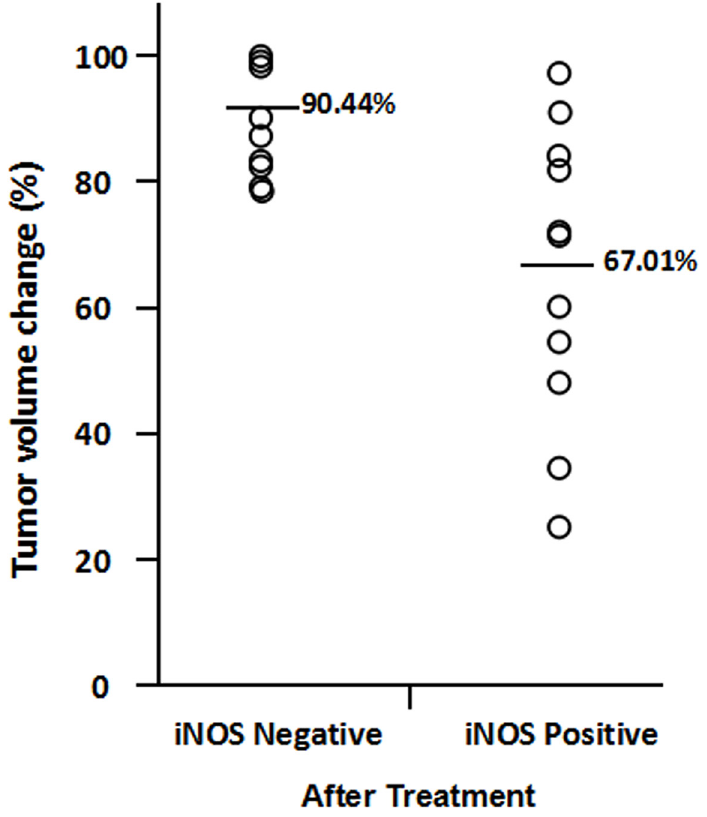
Fig 4. Comparison of tumor volume reduction in TNBC patients between positive expression of iNOS and negative expression of iNOS after neoadjuvant chemotherapy.